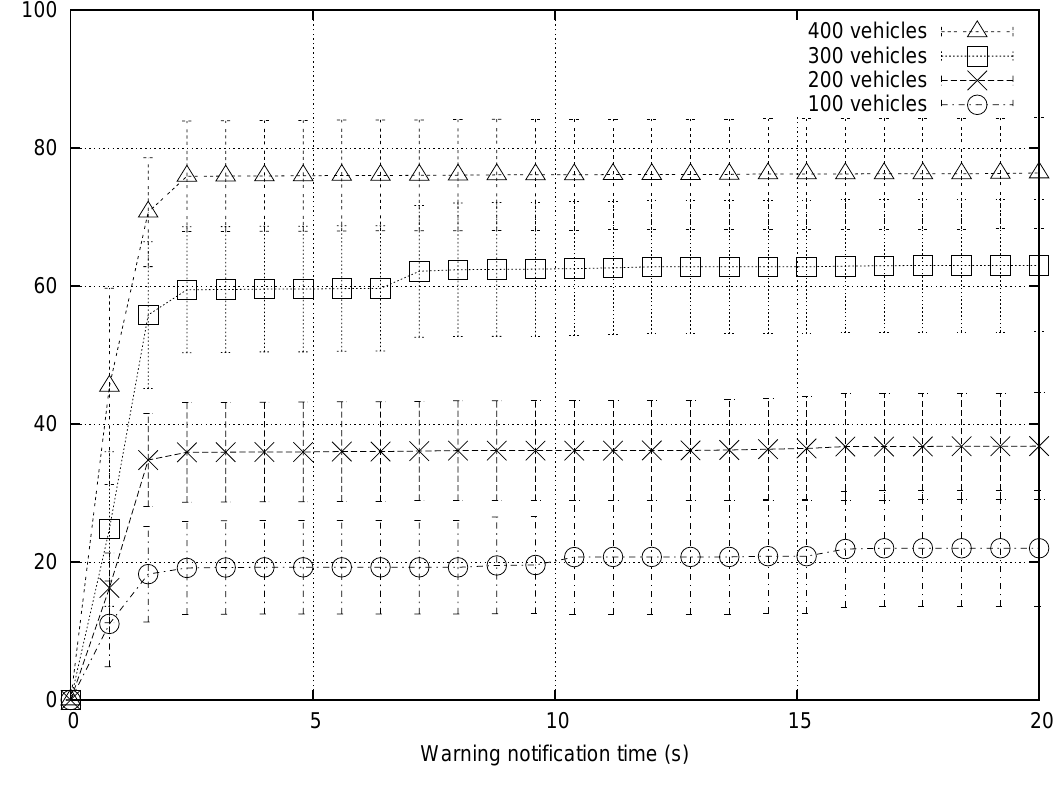
Table 8. Blind vehicles and packets received per vehicle when varying the density of